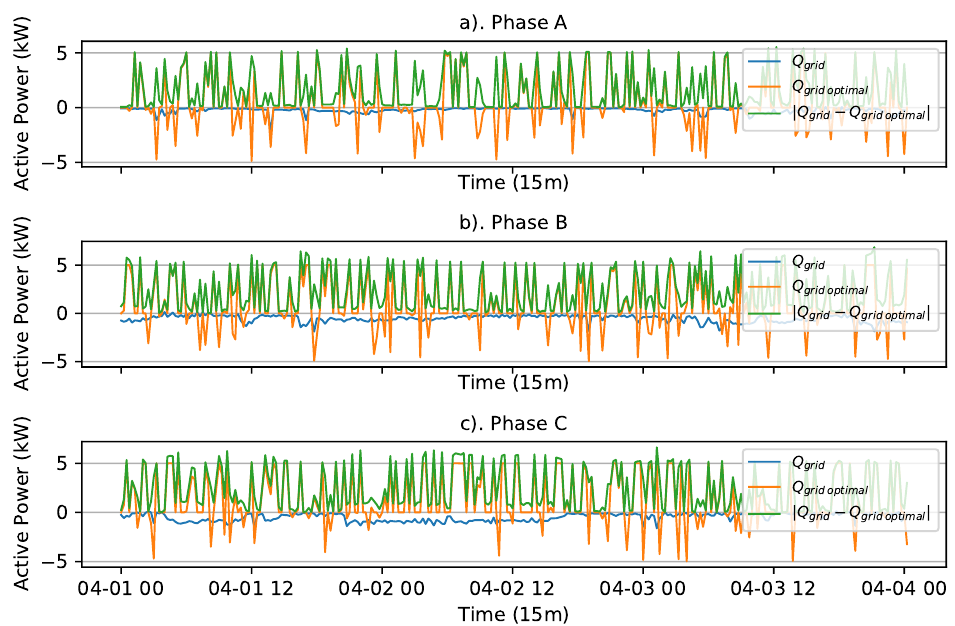
Figure 8. Per phase reactive powers at the point of common coupling, optimal grid schedule and the absolute difference between them at Bus 020. Due to the lack of reactive power control in flexibility models and devices working at a fixed power factor, reference profiles are not being followed when compared to active power tracking in Figure 7. This is done for the sake of simplicity, to maintain the linearity of flexibility models and their controllers.